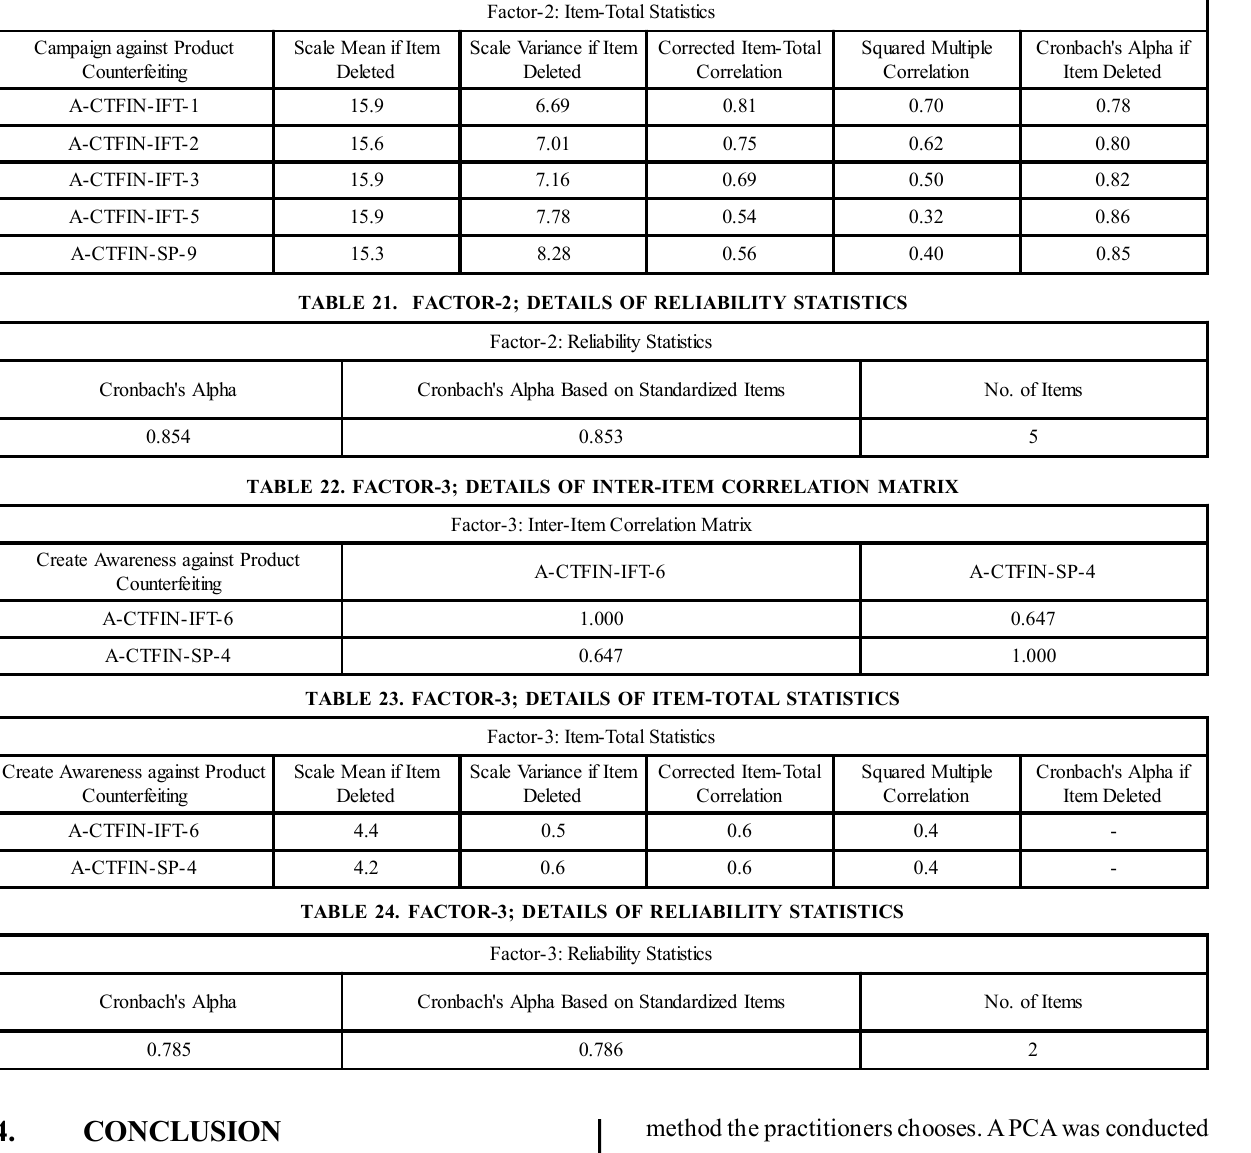
TABLE 20. FACTOR-2; DETAILS OF ITEM-TOTAL STATISTICS